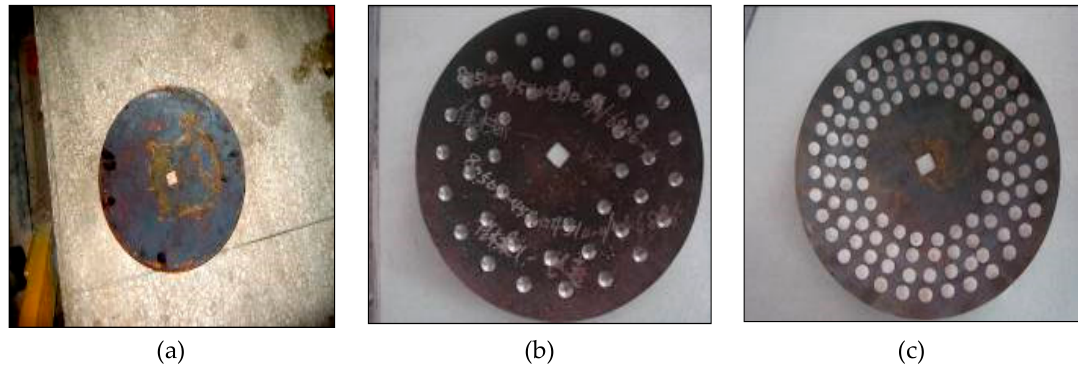
Figure 4. Bionic discs. ( a ) Plain disc; ( b ) bionic concave disc; ( c ) bionic convex disc.